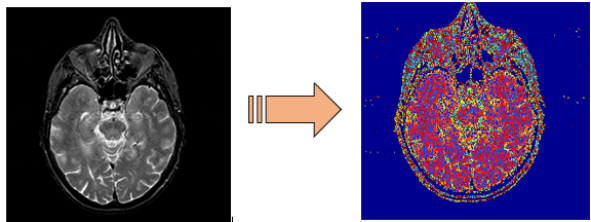
Figure 2. Normal image ( left ) and RGB image ( right ).